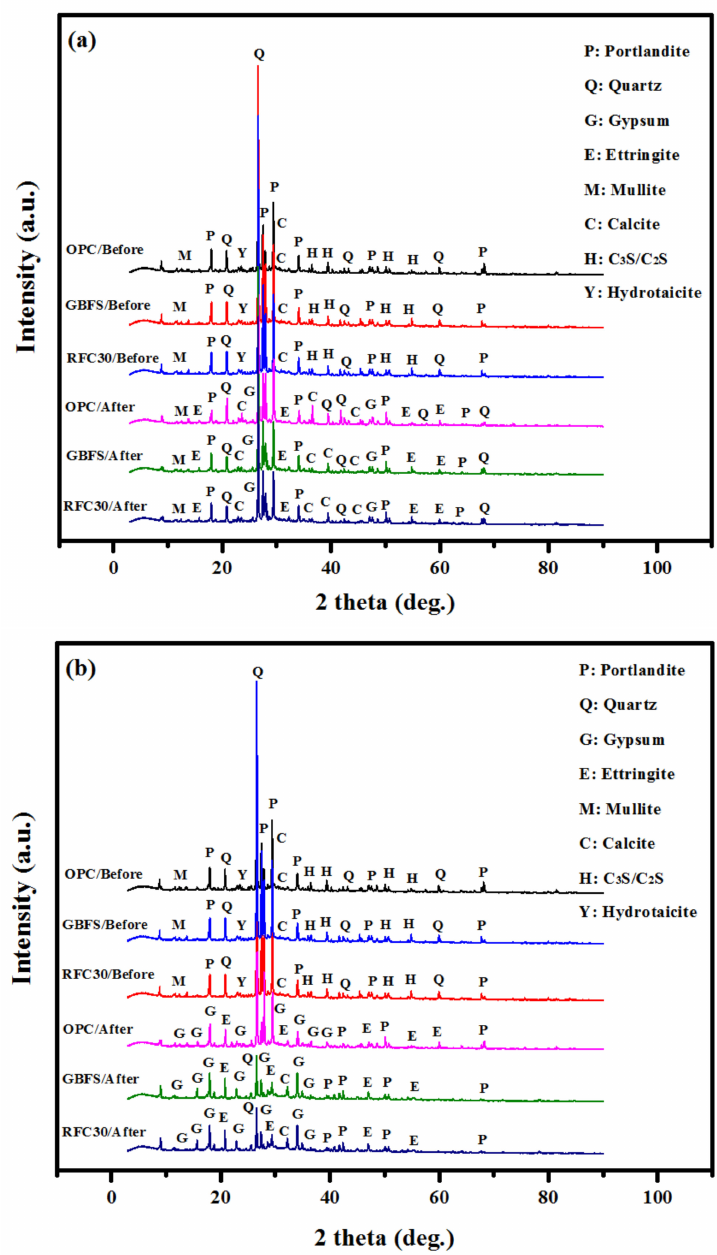
Figure 6. XRD patterns of the control (OPC), GBFS modified, and modified rubberized concrete (RFC30) ( a ) before and ( b ) after immersion in MgSO 4 and H 2 SO 4 solutions for 365 days. Figure 6b indicates that the gypsum’s peak intensity appeared at 29.7 ◦ after